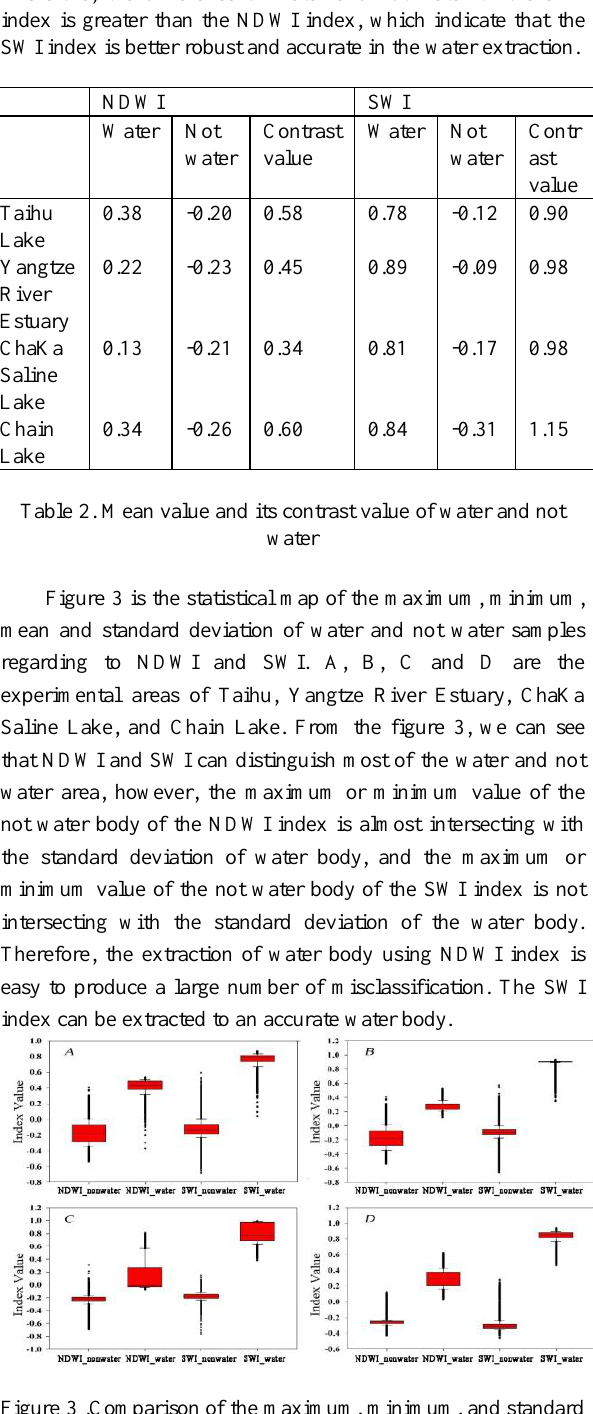
Figure 3 .Comparison of the maximum, minimum, and standard deviations of the NDWI and SWI index (A is Taihu Lake, B is Yangtze River Estuary, C is ChaKa Saline Lake, D is Chain